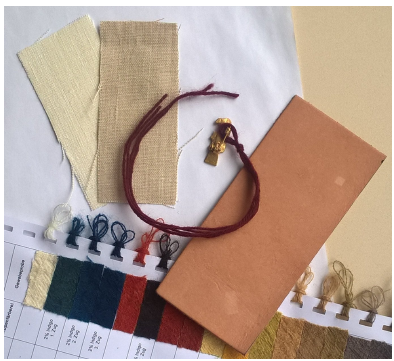
Figure 3. Photography of the examined test samples. Two different types of woven fabrics made of linen and hemp are shown in the top left corner. On the right side lies a piece of cowhide leather. Between the cloth and the leather, a replicated bird fibula is placed. The bottom row shows strands of dyed wool.